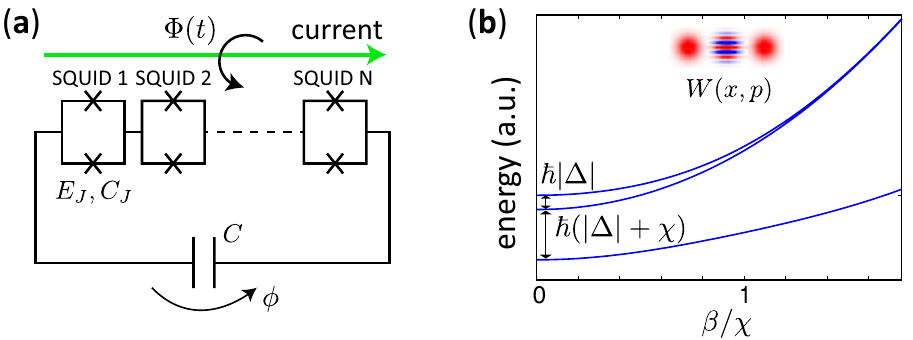
Figure 1. ( a ) Schematic of a superconducting quantum parametron. E J and C J are the Josephson energy of a single SQUID and the capacitance of a single Josephson junction, respectively. C denotes the capacitor shunting the SQUID array. φ is the overall phase across the junction array. �( t ) is the external magnetic flux threading the SQUIDs. ( b ) Energy level diagram as a function of pump strength for � < 0 and χ > 0 . Because � < 0 , 0 . The inset is a typical image of the Wigner function of the the highest energy level is the vacuum state for β = 2.5 ) . The top two curves overlap as β is sufficiently highest energy level for large √ 2 β/χ( ≃